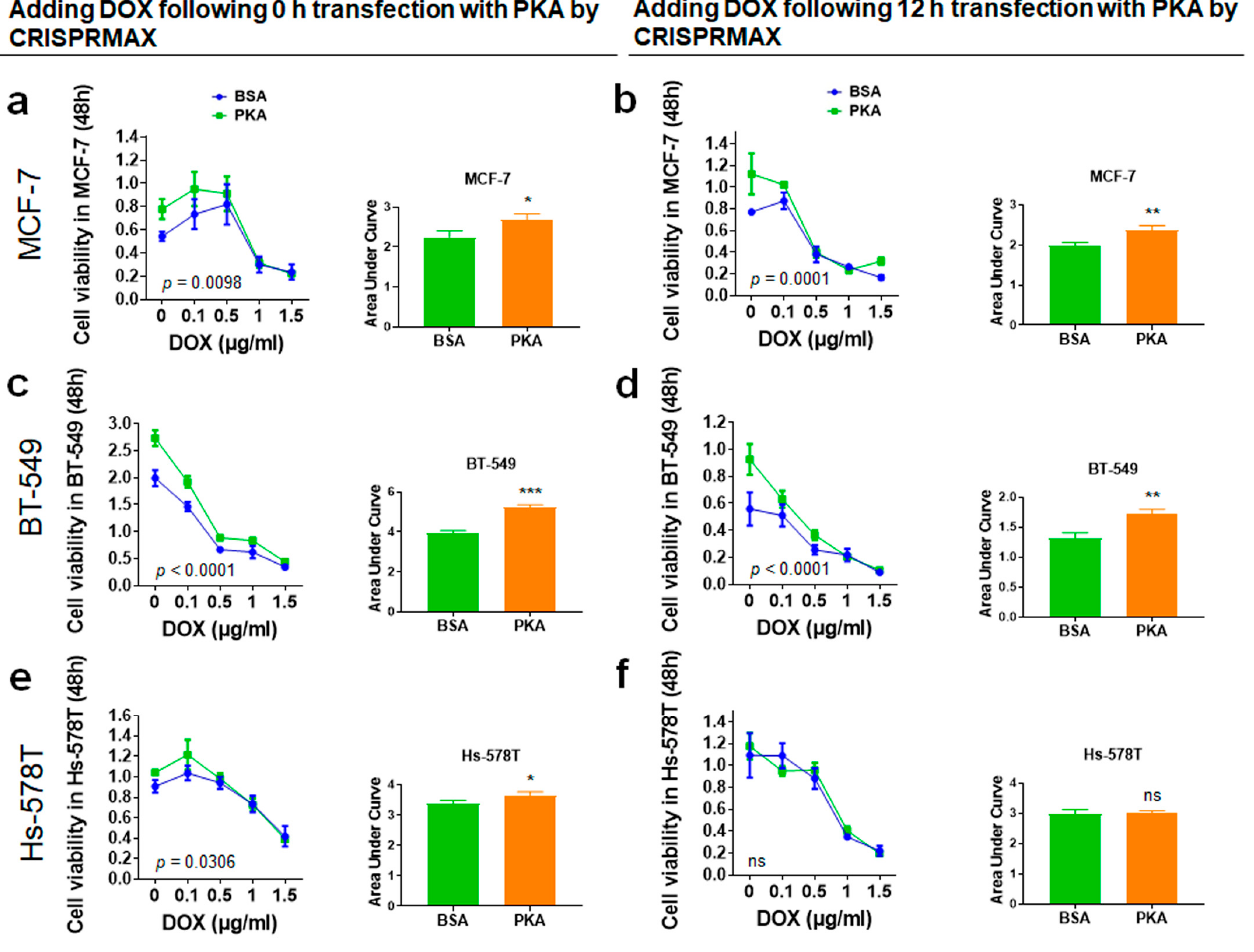
Figure 7. Chemoresistance evaluation of DOX in the cells following 0 or 12 h transfection with CRISPRMAX-PKAs. ( a , c , e ) Adding DOX following 0 h of transfection with CRISPRMAX-PKAs: MCF-7, BT-549, and Hs-578T cells were transfected with PKA by CRISPRMAX and treated with DOX at 0, 0.1, 0.5, 1, and 1.5 μ g/mL simultaneously for 48 h; the results of AUC analyses in MCF-7, BT-549, and Hs-578T were compared with the BSA control group ( p = 0.02094, p = 0.0002, p = 0.0425, respectively). ( b , d , f ) Cells were treated with DOX for 48 h following 12 h of transfection with CRISPRMAX-PKAs; the results of AUC analyses in MCF-7, BT-549, and Hs-578T were compared with the BSA control group ( p = 0.0067, p = 0.0043, p = 0.8200, respectively). AUC analyses were used to compare the effectiveness of the drug effect between the BSA and PKA group. All treatments were performed with WST-1 cell viability assays and AUC analyses. Data were presented as Mean ± SD ( n = 3 replicates for transfection with the PKA and BSA group). In total, 500 ng of PKA and BSA (control) per setup were used, and the PKA group was compared with the BSA control in each setup. Statistical significances were evaluated using unpaired two-tailed t test; * p < 0.05, ** p < 0.01, *** p < 0.001, and ns, not significant. DOX, doxorubicin.